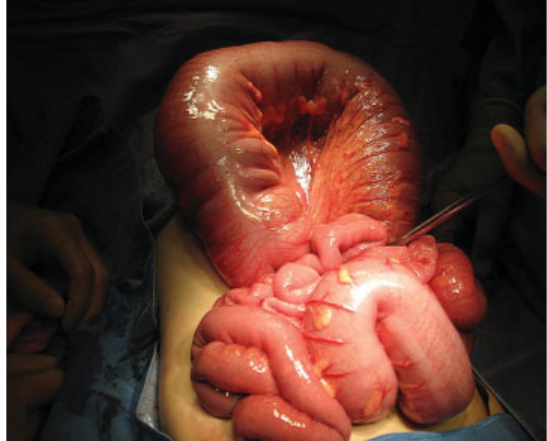
Fig. 2 Image showing the transverse colon following detorsion of the 270-degree